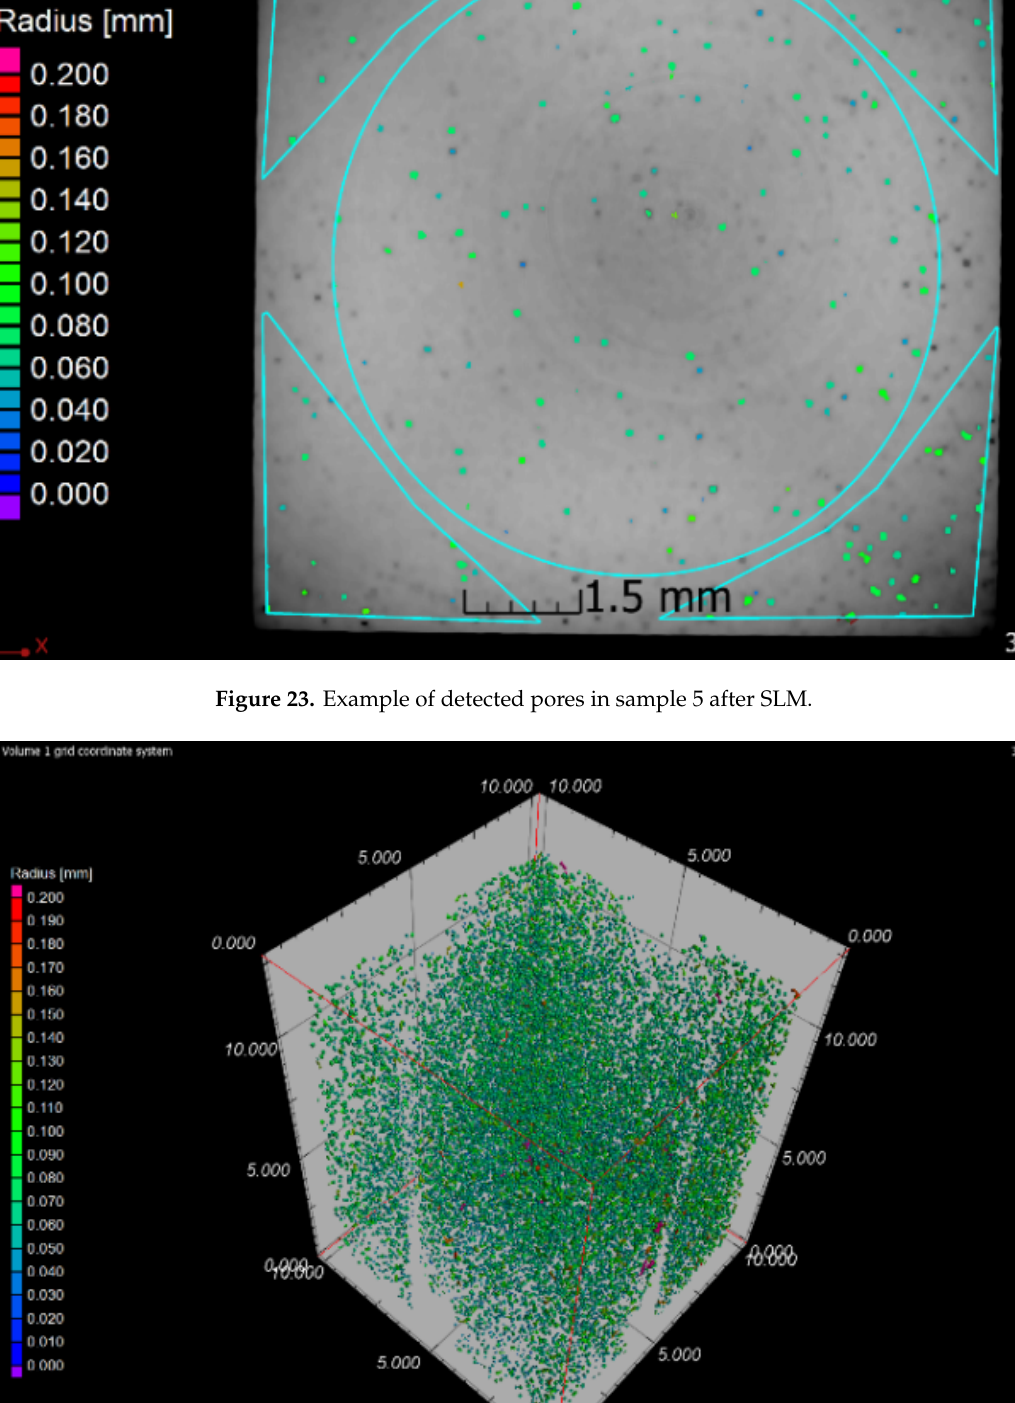
Figure 24. 3D illustration of pore distribution in sample 5 after SLM.